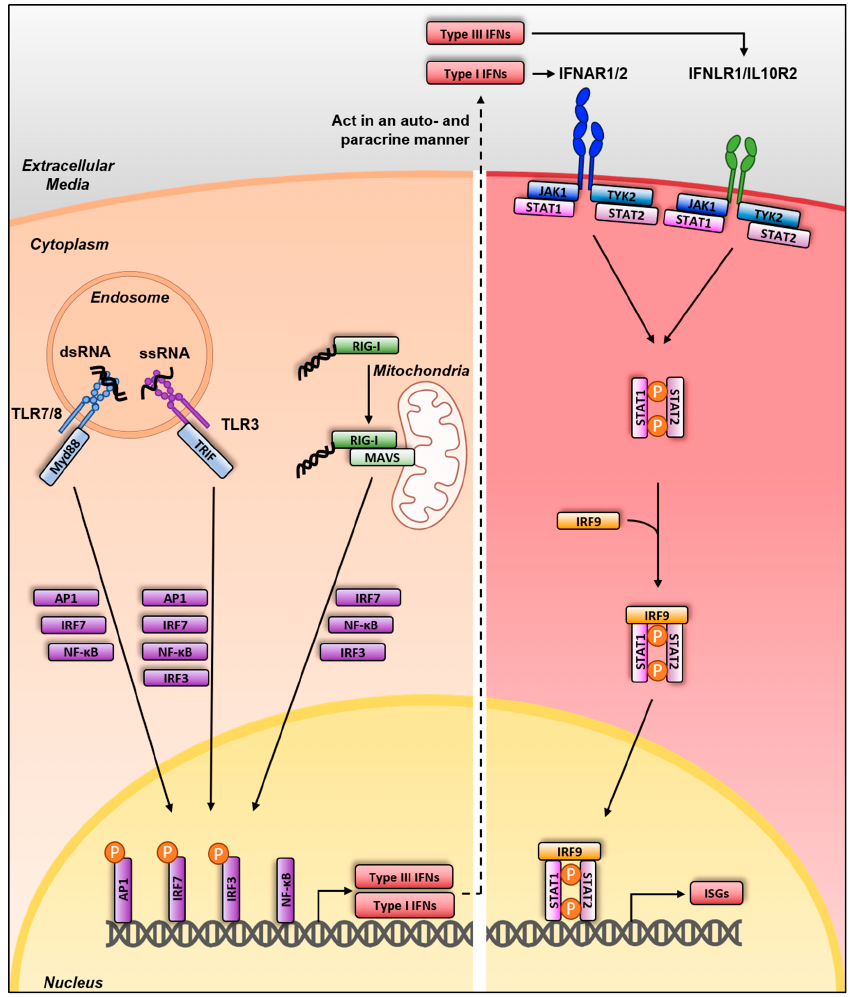
Figure 2. Schematic representation of IAV sensing and subsequent IFN signaling.